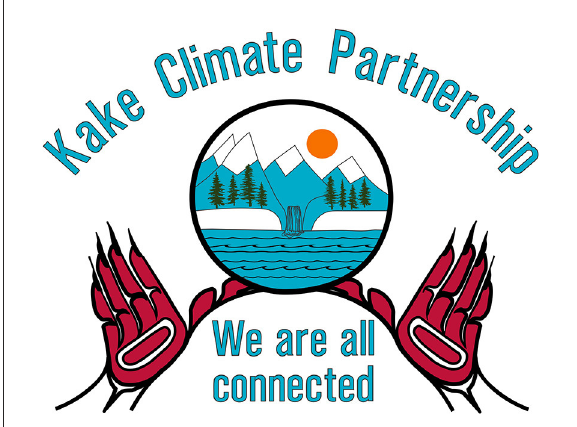
FIGURE6 A mixture of traditional Tlingit formline drawing techniques and European line drawing techniques to display connections in the Kake Climate Partnership. Two hands are pictured in the figure, holding up a rendition of a pristine natural environment pictured inside a circle (mountains, forests, water, sun). One hand represents Traditional Knowledge and the other represents Western science. Both hands share a vision of a pristine environment with clean water and healthy forests. The two hands are coming together with a common goal to protect and maintain that pristine natural environment through understanding climate change and adapting to it. Each hand is reaching out to the pristine environment, emphasizing that partners are all connected and have a common goal of preserving the natural environment as best we can. The phrase underneath the hands, ‘We are all connected’, communicates a shared vision among partners that everything is connected—partners have a shared vision of unity and common goals for the future. The phrase, ‘Kake Climate Partnership’, forms the top of the drawing, symbolizing how it is made possible through the two hands of Traditional Knowledge and Western science working together. Artist credit: B. Ki’yee Jackson; digitized by Lori Styczynski at Roy’s Embroidery, in Juneau,